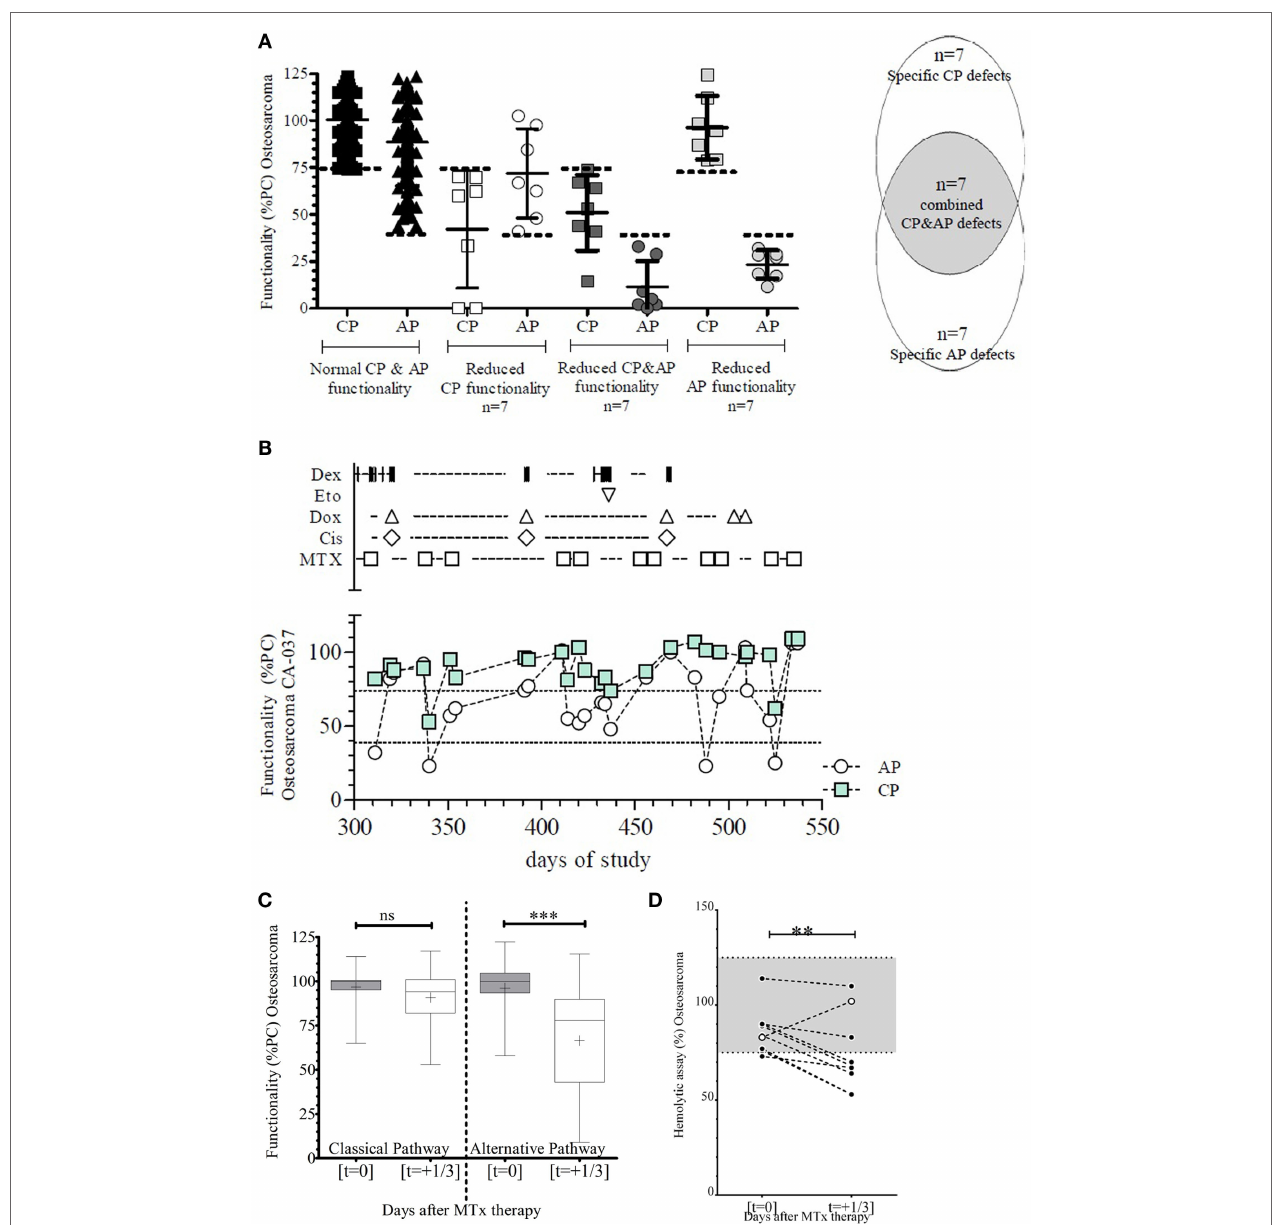
FigUre 6 | classical (cP) and alternative (aP) pathway complement functionality of patients with osteosarcoma receiving high-dose methotrexate (MTX) treatment . (a) Functionality of the complement system of all patients ( n = 7) with osteosarcoma showed few specific CP defects ( n = 7) with a similar number of specific AP defects or defects in both pathways. The dotted line depicts the lower limit of functionality for CP functionality ( < 75%) and AP functionality ( < 40%) as determined for the WIELISA assay. Functionality is depicted as percentage of a positive control (%PC). (B) Representative figure of one patient with osteosarcoma showing the different treatment compounds with the respective effect on the functionality of the complement system in a longitudinal setting (Dex: cyclofosfamide, Eto: etoposide, Dox: doxorubicin, Cis: cisplatin, MTX: methotrexate). Functionality is depicted as percentage of a positive control (%PC). (c) Combined time points ( n = 21) from all patients within the EURAMOS I protocol receiving high-dose MTX therapy. The CP was not affected before or after MTX, whereas the AP showed a significant decrease in functionality (*** p < 0.001). Box whiskers depict the min–max values; mean is indicated by a plus symbol. Functionality is depicted as percentage of a positive control (%PC). (D) The activity of the alternative pathway measured by the ability to induce hemolysis of